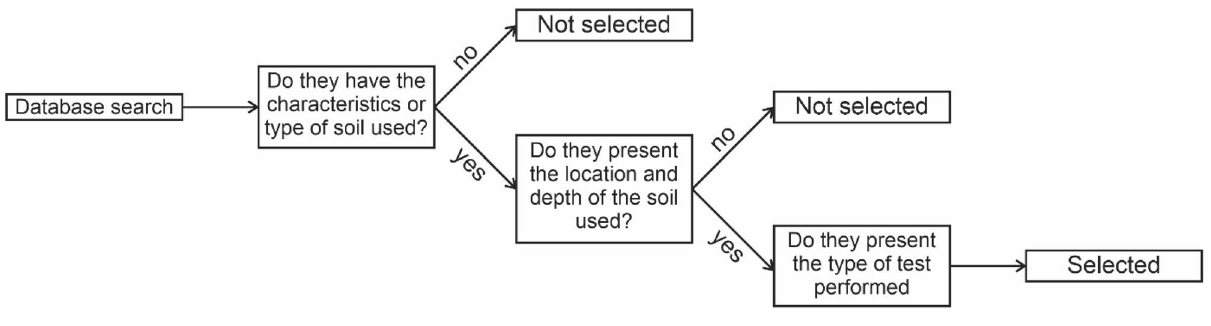
Figure 1. Criteria for selecting